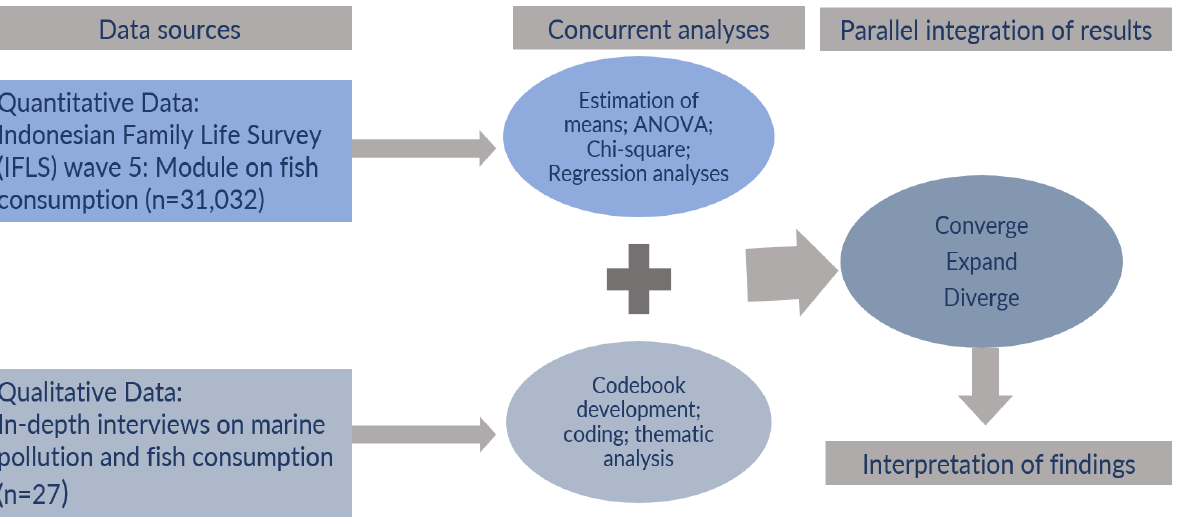
Figure 1. Study Flowchart for the Convergent Mixed-Methods Design.